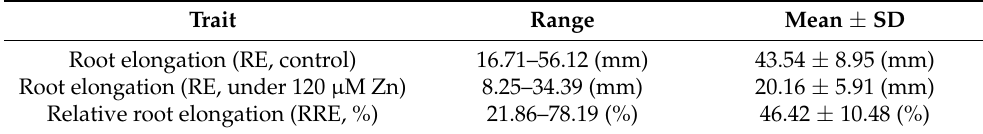
Figure 1. GWAS of Zn tolerance by using EMMAX model. ( a ) Distribution of root elongation of Ting’s core collection growing under Zn toxicity (120 µ M); ( b ) Manhattan plot of GWAS using root elongation under Zn toxicity (120 µ M); ( c ) distribution of relative root elongation of Ting’s core collection growing under Zn toxicity (120 µ M); and ( d ) Manhattan plot of GWAS using relative root elongation. Chromosomes are depicted in different colors. The horizontal green dashed line indicates the significance threshold ( − log10(mBF) = 5.02). The black arrows represent the novel loci associated with Zn tolerance detected in the present study. The red arrow represents the loci, which were reported previously. Table 1. Performance of Ting’s core collection under control conditions and Zn toxicity.